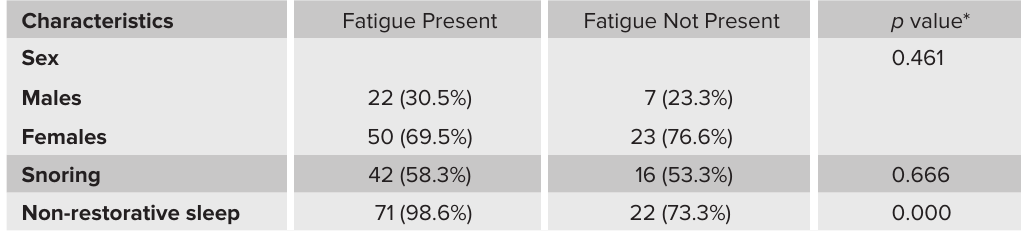
Table 2: A Comparison Between Diabetic Patients with and Without Fatigue.